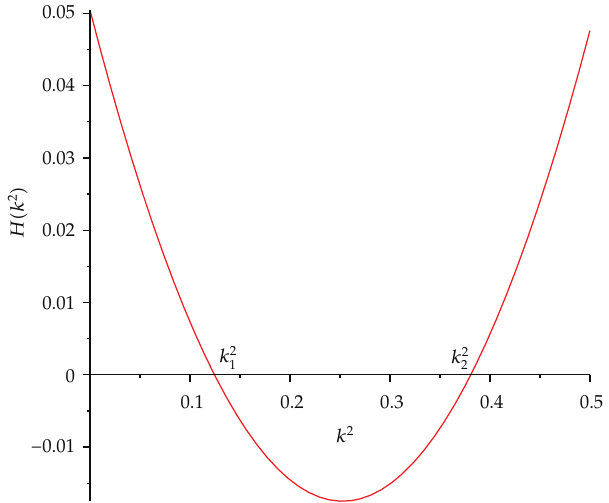
Figure 1: Modes with wavenumbers lying between the zeros, k 2 instability. Parameters: a (cid:6) 0 . 8 ,b (cid:6) 0 . 1 ,r (cid:6) 0 . 1 ,D 12 (cid:6) − 0 . 08 ,D 21 (cid:6) 0 . 8, hence, k 2 and H min (cid:6) − 0 .